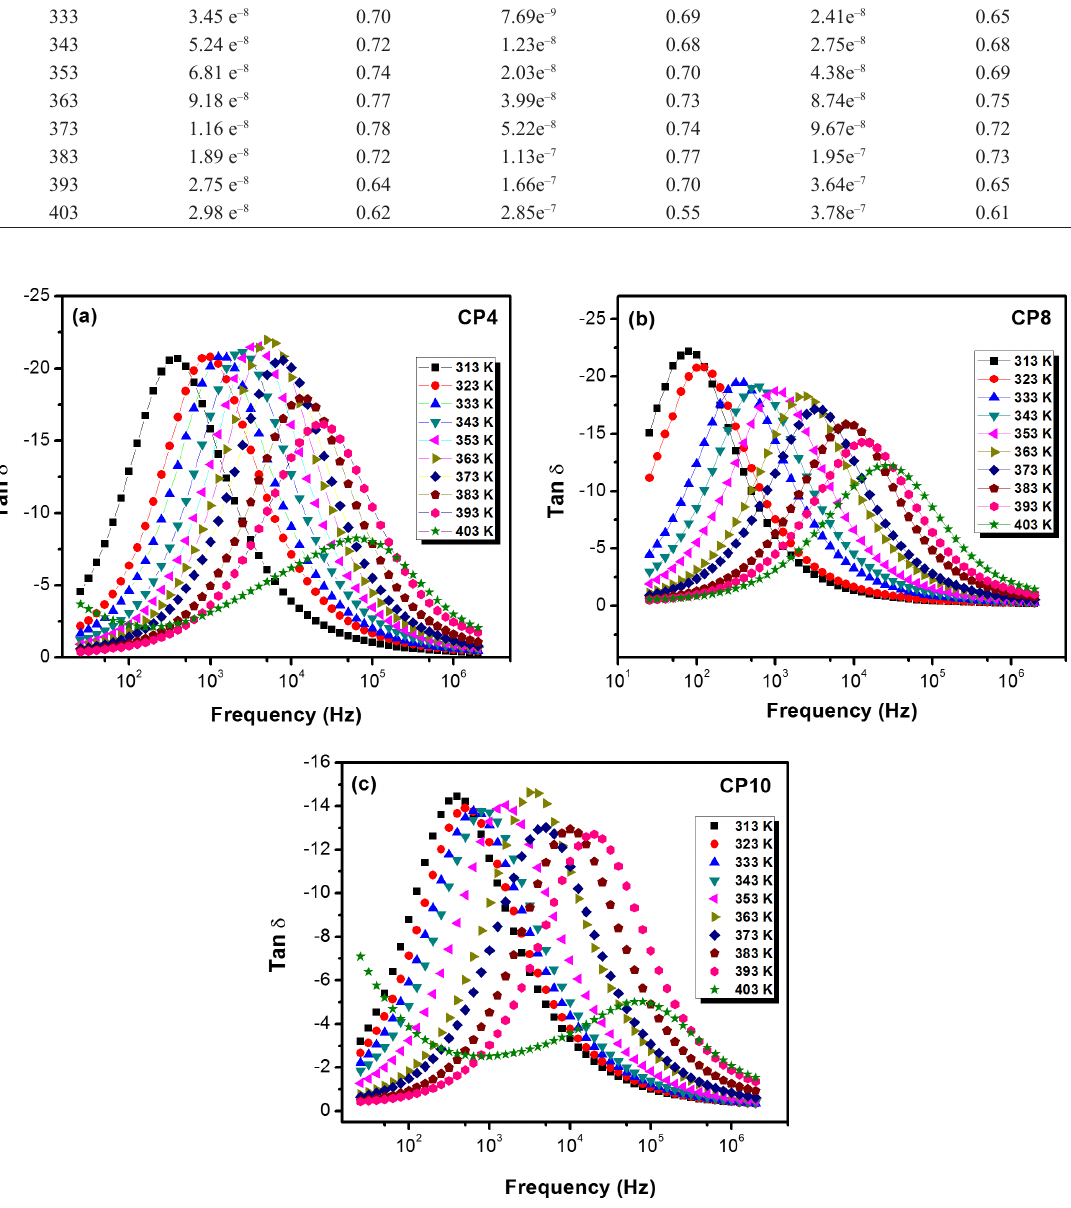
Figure 5. Variation of dielectric loss (tanδ) with frequency for synthsized blends at different tempearatures (a) CP4 (b) CP8 and (c)